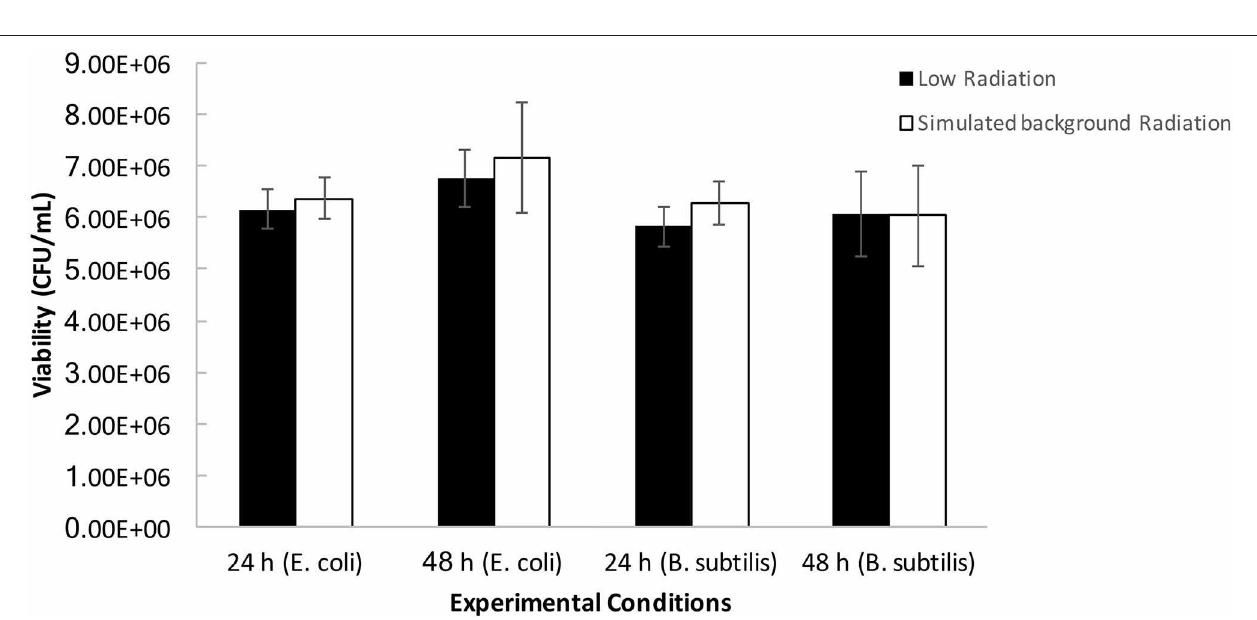
FIGURE 6 | Average ( n = 84) of B. subtilis growth curves at increased radiation dose rates: 10 × = 10 × the artificial background dose rate; 100 × = 100 × the artificial background dose rate; Low paired = samples run parallel at the low dose rate. Error bars show ± standard error ( n = 84).